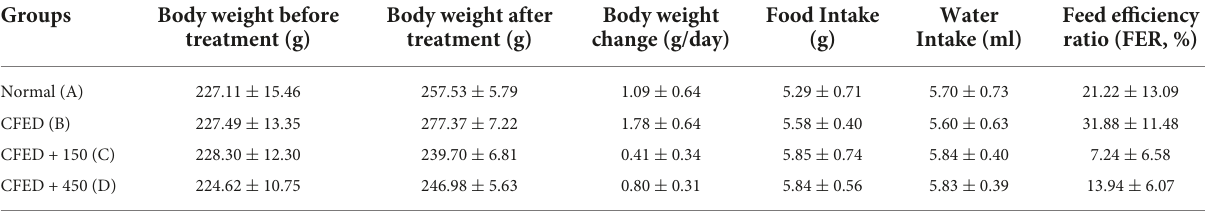
TABLE 1 Weight characteristics, food and water intake, and feed efficiency ratio between groups of experimental animals.